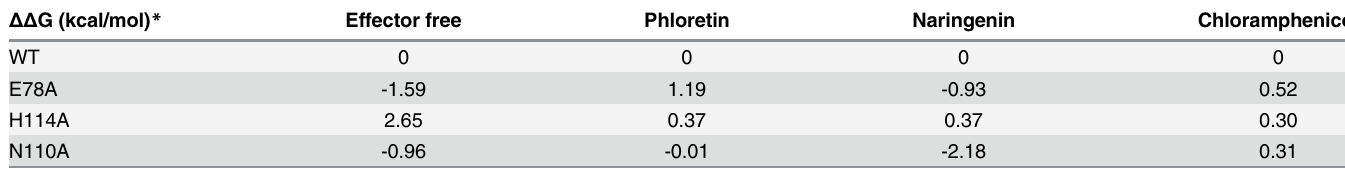
Table 3. Theoretical energy measurements of